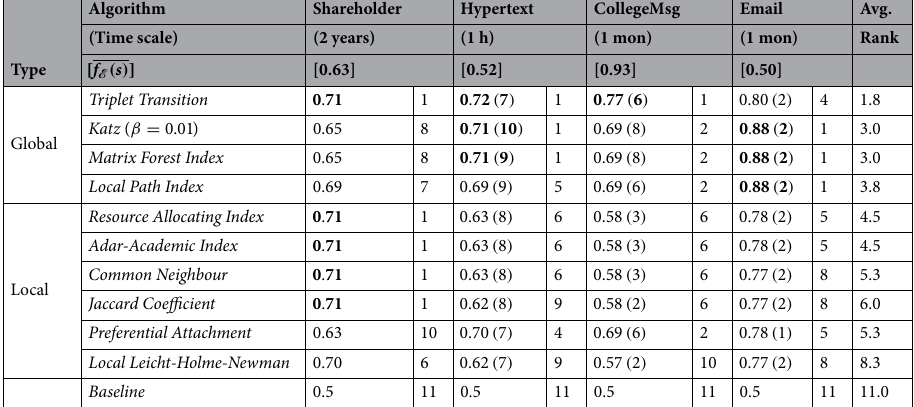
Table 4. Summary of AUC-ROC performance, (cid:31) t is taken by selecting the highest AUC-ROC. The AUC scores for each network are in the left-hand column, the rank of the score in the right-hand column. The errors quoted on the AUC scores are standard deviations from all the computed network snapshots of the selected time scale except for Turkish Shareholder networks where only two predictions are made. We highlight the highest result and any whose result is within the error quoted on the largest result. The baseline method for AUC is the random clustering of node pairs into two groups, and the AUC is 0.5 which means it is like ‘tossing a coin’. The Type column indicates if the link prediction method probes only ultra scales (path length two) or global scales (infinte path lengths).